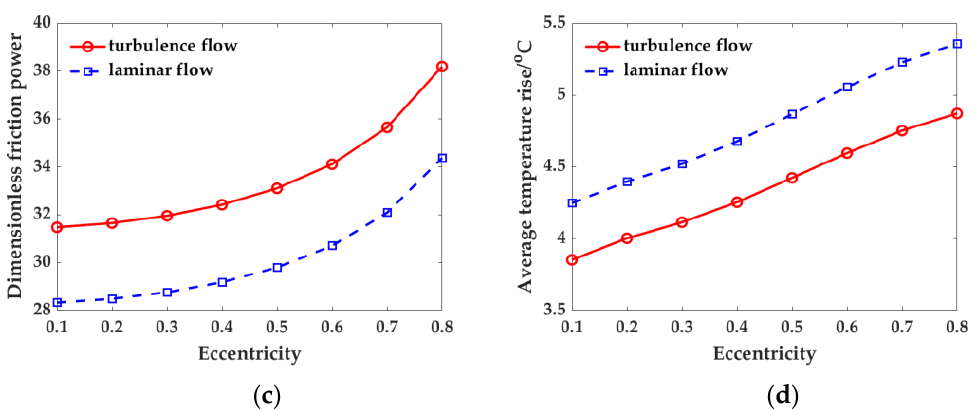
Figure 11. Performance comparison between the turbulence flow state and the laminar flow state. ( a ) Dimensionless load capacity ( b ) Side leakage ( c ) Dimensionless friction power ( d ) Average temperature rise.